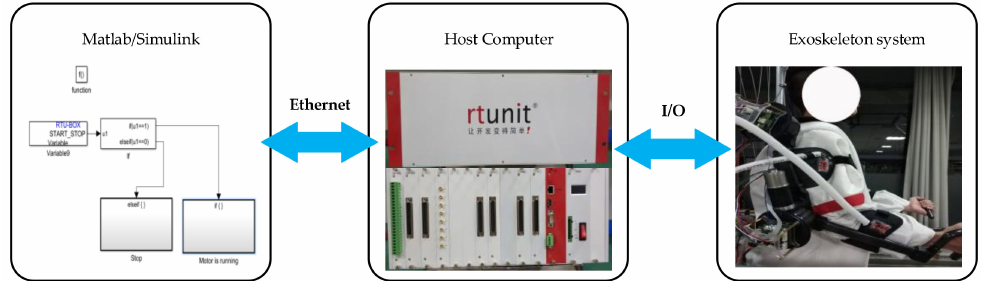
Figure 9. The real-time simulation